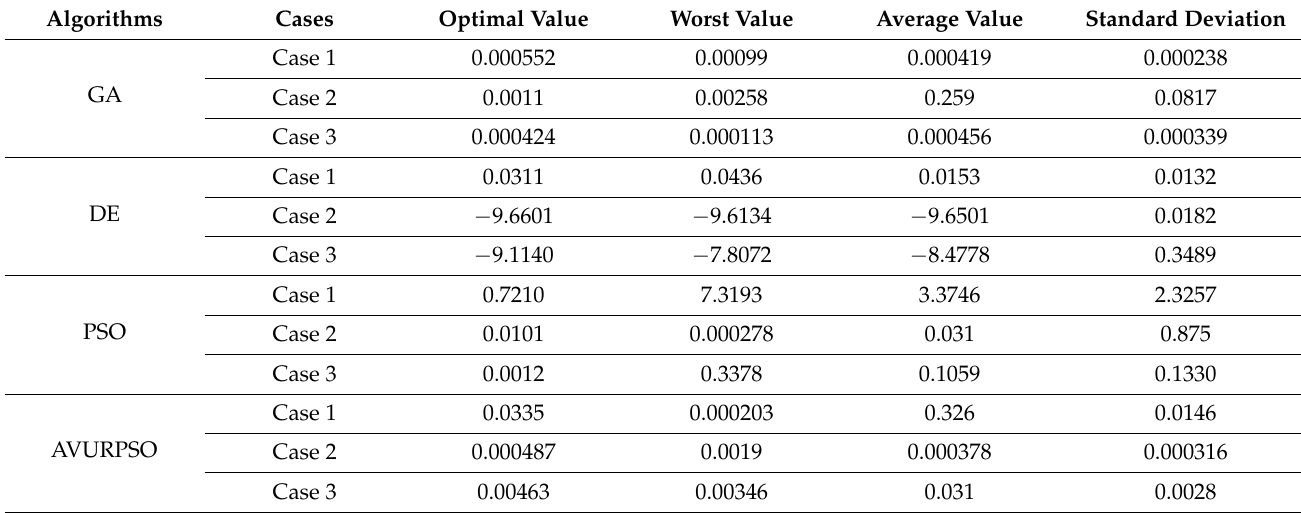
Figure 15. Average convergence accuracy of different algorithms. Table 2. Error comparison of different algorithms.